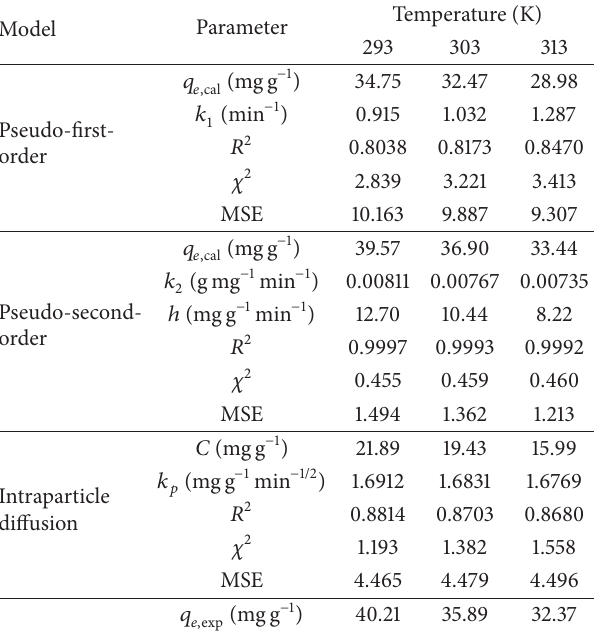
Table 2: Kinetic model parameters and constants with statistical data.